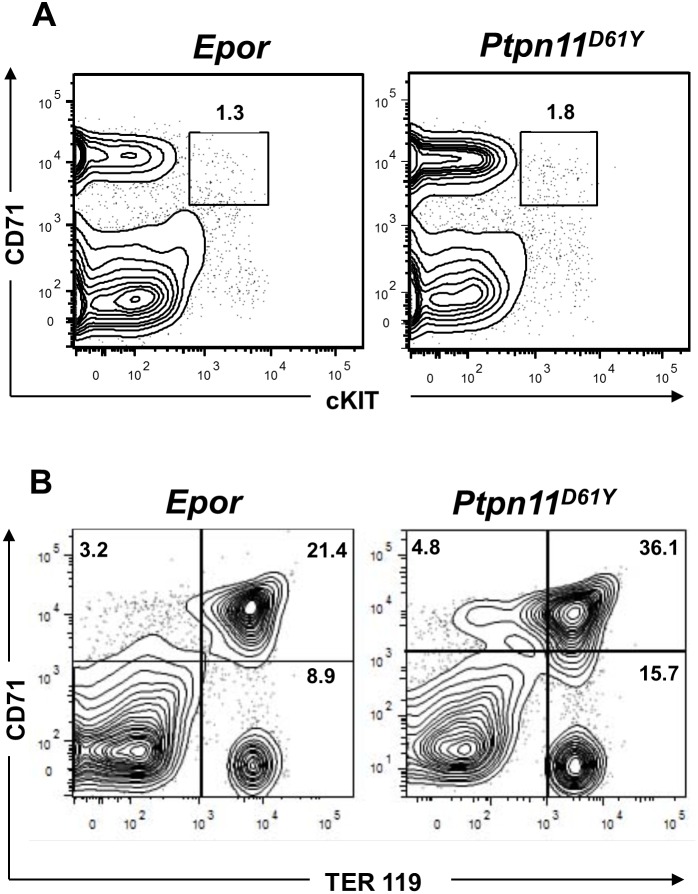
Altered erythroid differentiation of Ptpn11D61Y mice.(A, B) Representative flow cytometry profiles of BM cells from Epor and Ptpn11D61Y mice. Erythroid subsets include EP (cKIT+CD71+Ter119−) (A), and Pro EB (cKITl°CD71+TER119−) and Early EB (CD71+TER119+) (B). See Table 2 for frequencies and absolute numbers of each population.